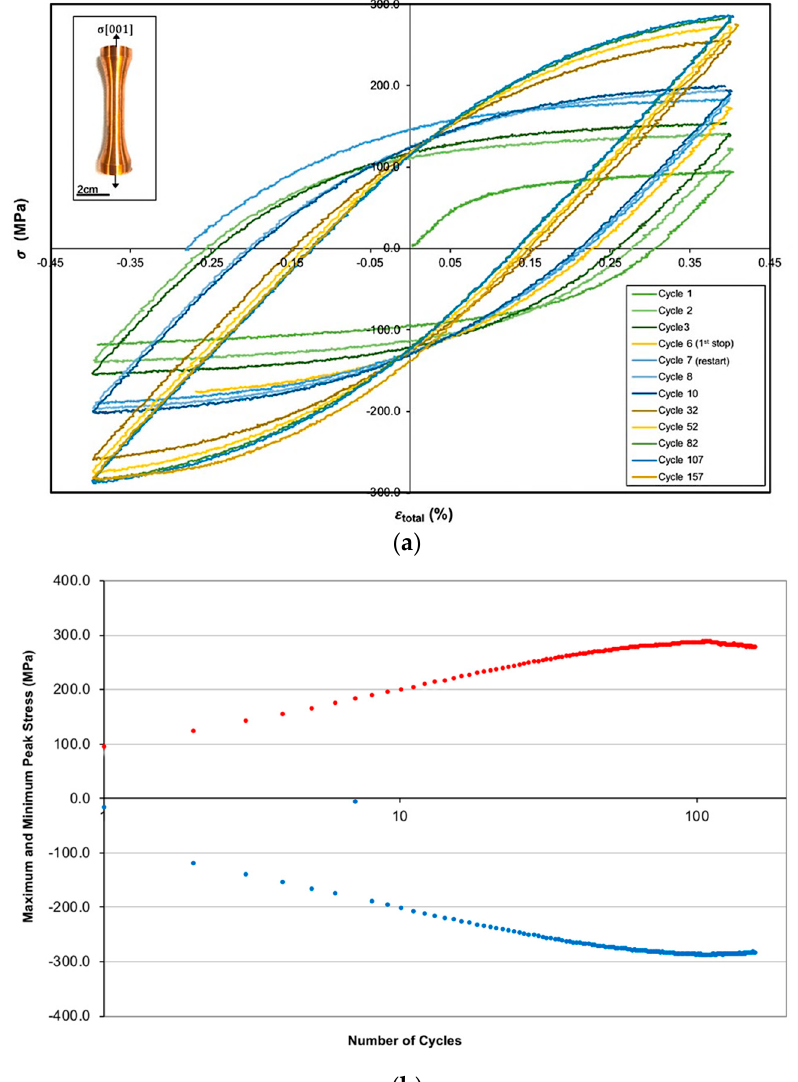
Figure 1. ( a ) The cyclic deformation of [001]-oriented copper single crystal at 298 K. Strains are plastic and elastic. ( b ) The evolution of the maximum and minimum peak stress versus the number of cycles confirms saturation is reached.